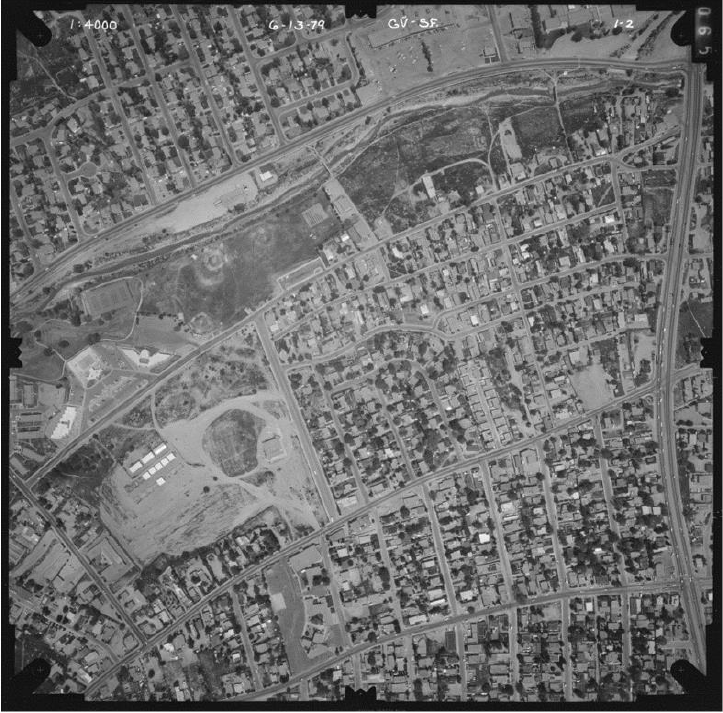
Figure 7. An example of printed (hardcopy) panchromatic historical aerial photos. This photo was collected on 13 June 1979 and it has a scale of 1:4000. It shows ground features in gray-scale.